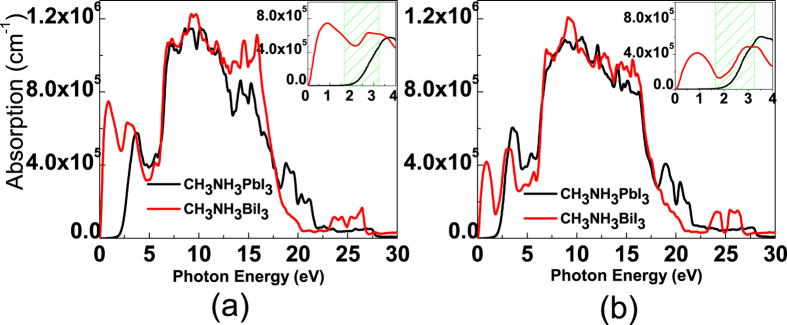
Calculated optical absorption spectrum of O-CH3NH3XI3(Pb Bi), (a), and T-CH3NH3XI3(Pb,Bi) (b).